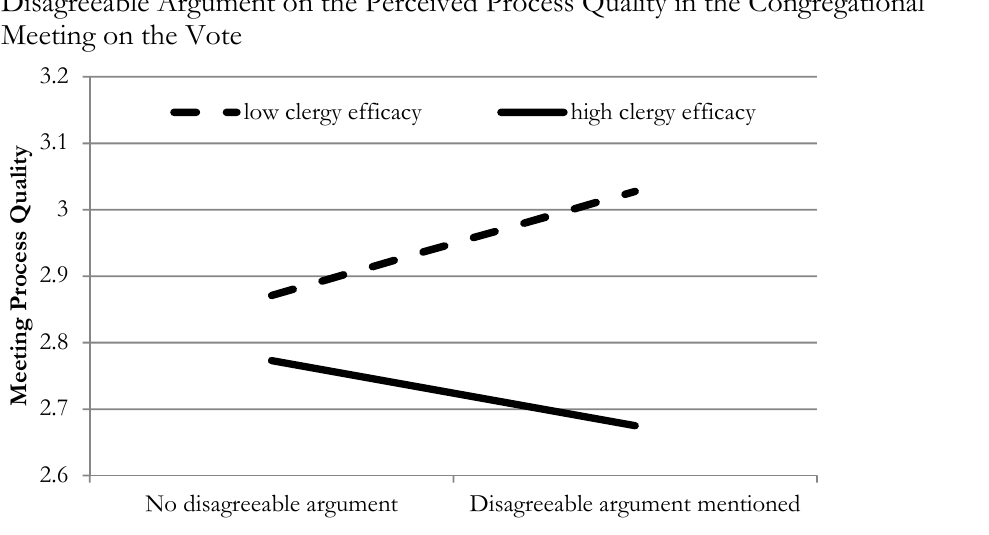
Source: 2009-2010 ELCA Clergy Surveys. Results from Table